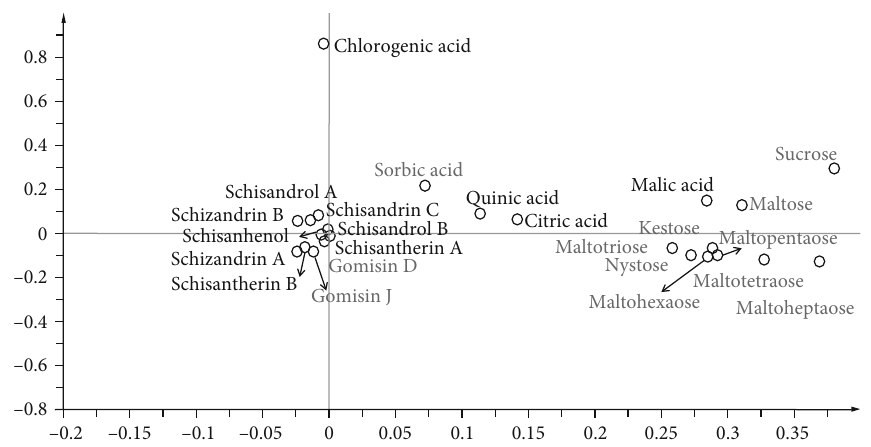
Figure 3: PLS-DA loading contribution diagram of lignans, organic acids, and